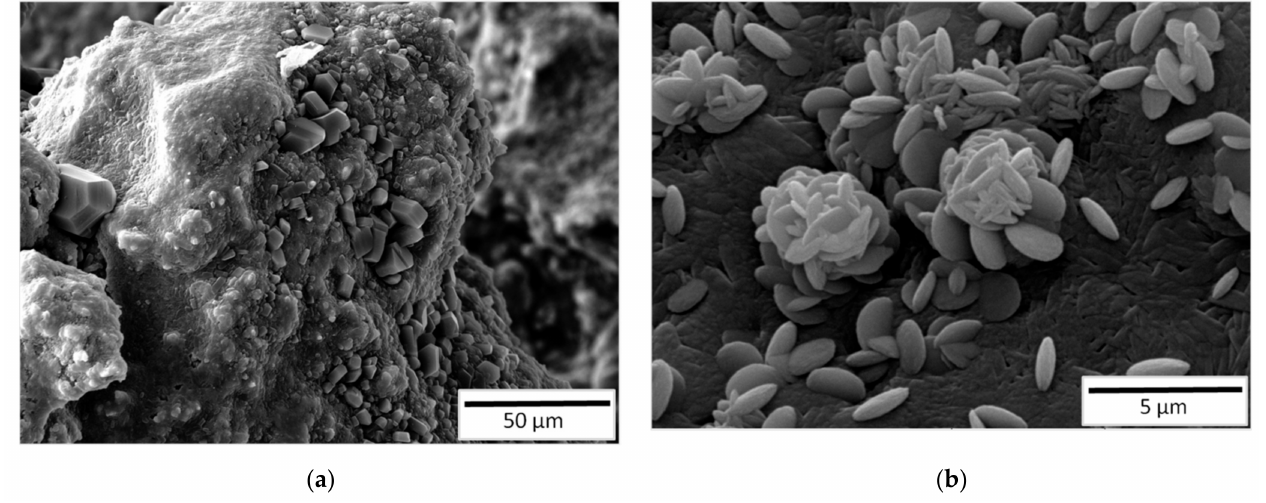
Figure 4. SEM images: single-layer monomineral biofilms: gibbsite ( a ) and hematite ( b ).